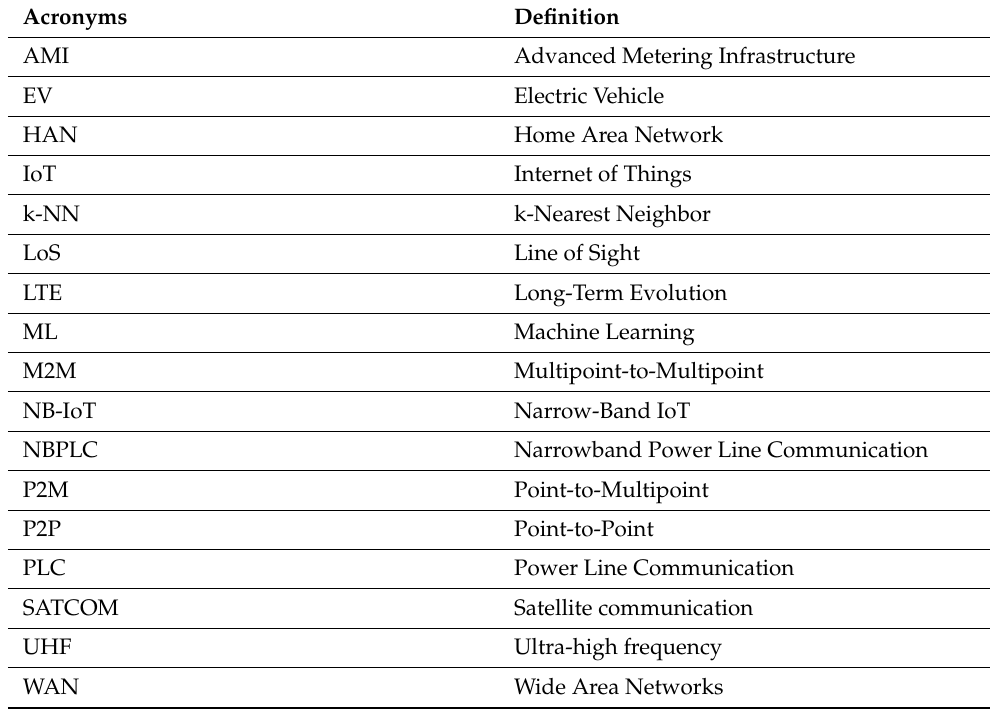
Table 1. Acronyms and